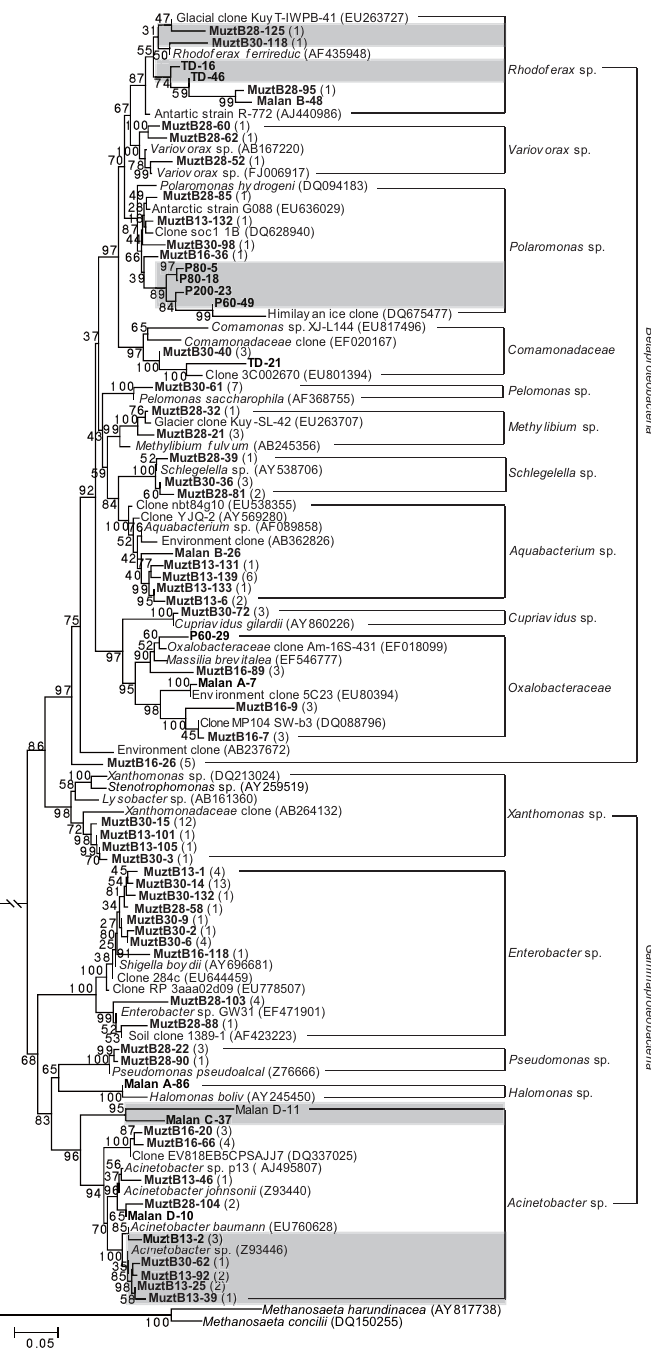
Fig. 3a. Phylogenetic analysis of the 16S rRNA genes for Betaproteobacteria and Gammaproteobacteria clones from the four ice cores and the closest relatives. The tree was generated by the Neighbour-Joining method after sequence alignment, and rooted with two Methanosaeta harundinacea strains (accession no. AY817738 and DQ150255). Bootstrap values (100 replications) were specified for each Node. Numbers of the obtained snow-ice clones (had the same ARDRA pattern to the sequenced representatives listed on the tree) and relative sequence affiliations corresponding to GenBank accession number were provided in parentheses. Scale bar indicated 0.05 substitutions per nucleotide. The sequences discussed in this study were noted bold. The Muztag Ata Glacier clones were represented by MuztB13 (1988 spring), MuztB16 (1984 autumn–1985 winter), MuztB28 (1972 spring–summer) and MuztB30 (1970 winter), the Puruogangri Glacier clones were noted by P60 (at 52m depth, AD 1850–1920), P80 (62m depth, AD 1750–1800), and P200 (89m depth, AD 1600–1700), while the Malan Glacier clones were noted by Malan A (35m depth, AD 1800), Malan B (64m depth, AD 1600), Malan C (70m depth, AD 1560), and Malan D (82 m depth, AD 1400). The typical endemic cluster was indicated in the gray shaded areas (same for the following Figs). See a detailed description for the assigned sequence references and numbers in materials and